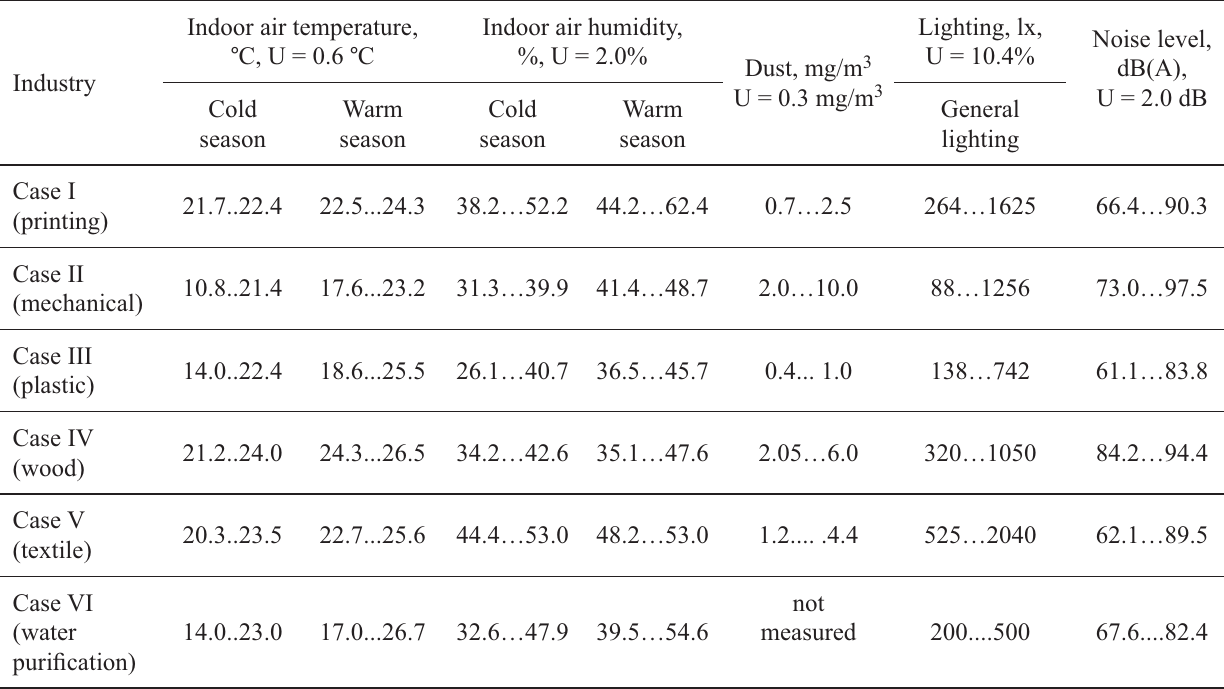
Table 2. Overall results of measurements of working conditions in manufacturing (Reinhold and Tint 2009)